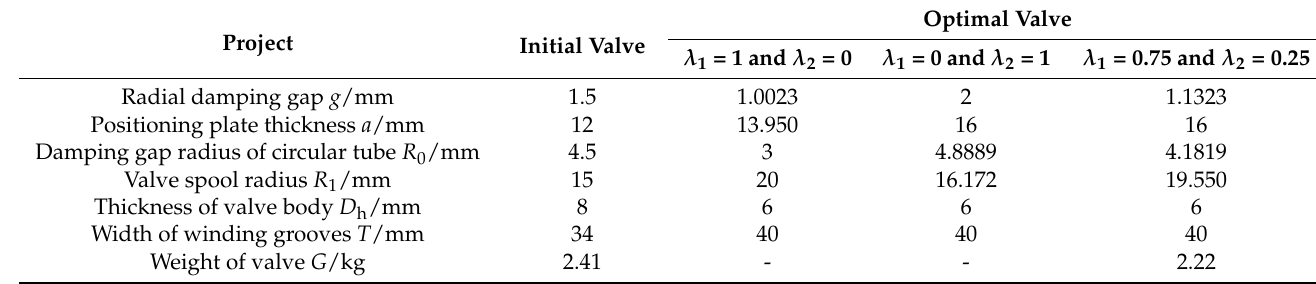
Table 2. Weight and sizes of the initial and optimal radial MR